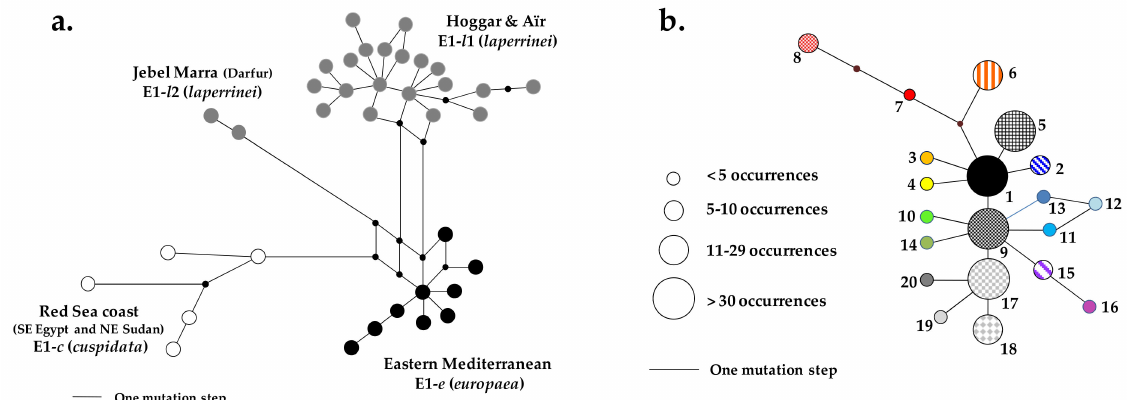
Figure 2. Reduced-median networks [44] of chlorotypes belonging to ( a ) lineage E1 and ( b ) sublineage E1- l 1. Each chlorotype is represented by a circle. ( a ) Four main E1 sublineages are identified: two in Central Sahara (grey), one on the Red Sea Coast (white), and one in the eastern Mediterranean Basin (black) (modified from [11]). All Laperrine’s olive individuals from Central Sahara belong to sublineage E1- l 1, whereas those of Jebel Marra (Darfur) belong to E1- l 2; ( b ) On the E1- l 1 network, the 20 chlorotypes are distinguished with a specific color and pattern (for their geographic distribution, see Figure 3). For each chlorotype, circle size is proportional to the number of occurrences within our